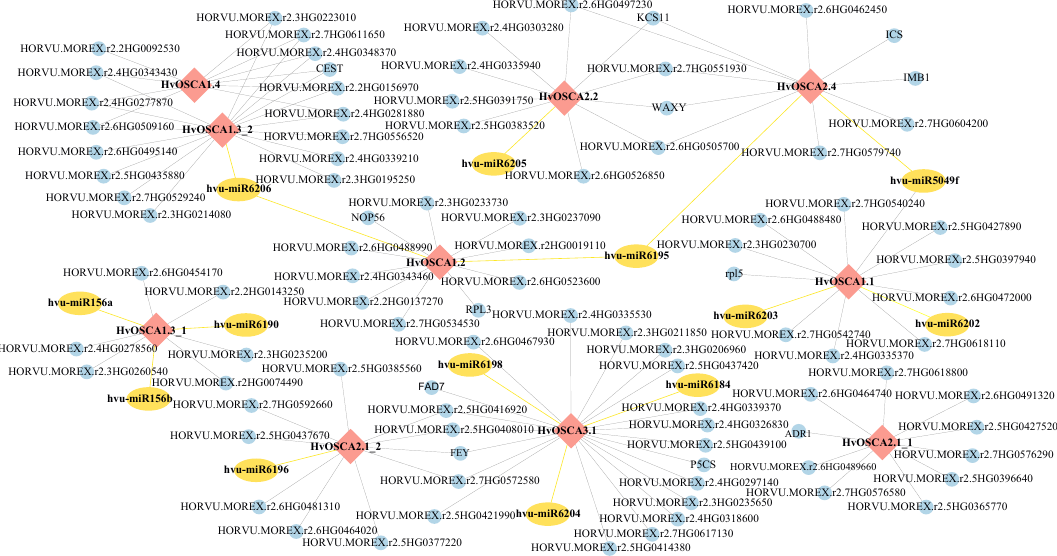
Figure 5. miRNA ¬ –mRNA interaction network of HvOSCAs involving responses to abiotic stresses. The HvOSCAs are represented by the red diamonds, the predicted miRNAs by yellow ovals and the other interacting genes by blue